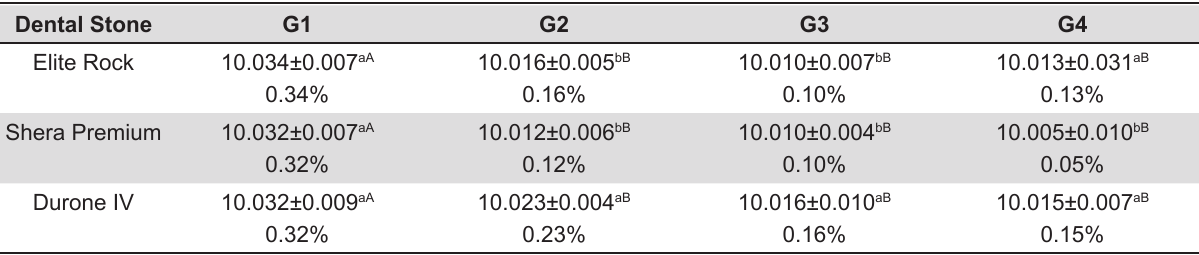
Table 2- Mean linear dimensional change (mm), standard deviation and percentage of dimensional change as function of the drying method and stone type Dental Stone